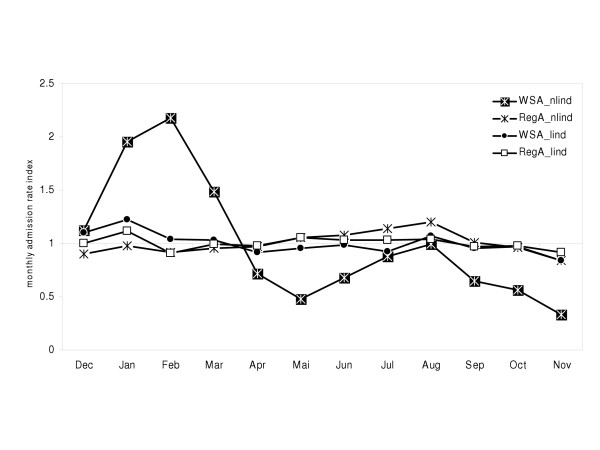
Monthly admission index of nonlocal and local residents in WSA and RegA HSAo. Monthly admission index of nl-res and l-res in winter sport (WSA) and regular (RegA) HSAo; 2000–2002. Nlind = nl-res admission index, lind = l-res admission index.